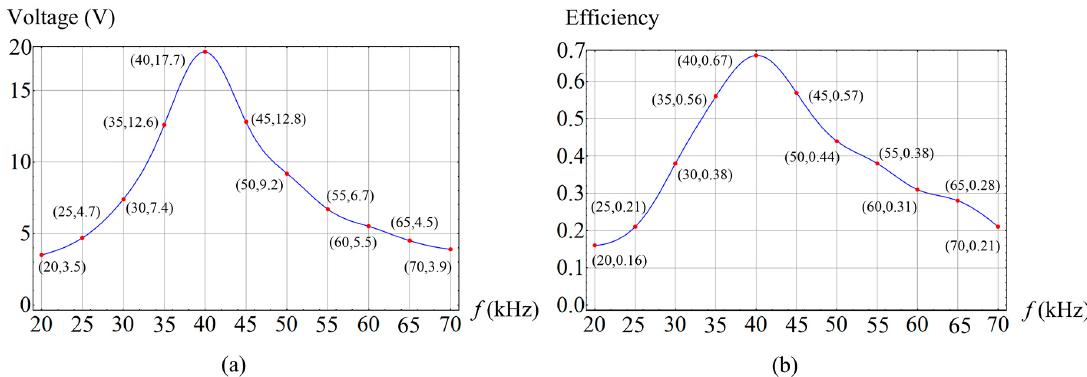
Figure 20. ( a ) Experiment results of load voltage related to frequencies; ( b ) Experiment results of efficiency related to frequencies.